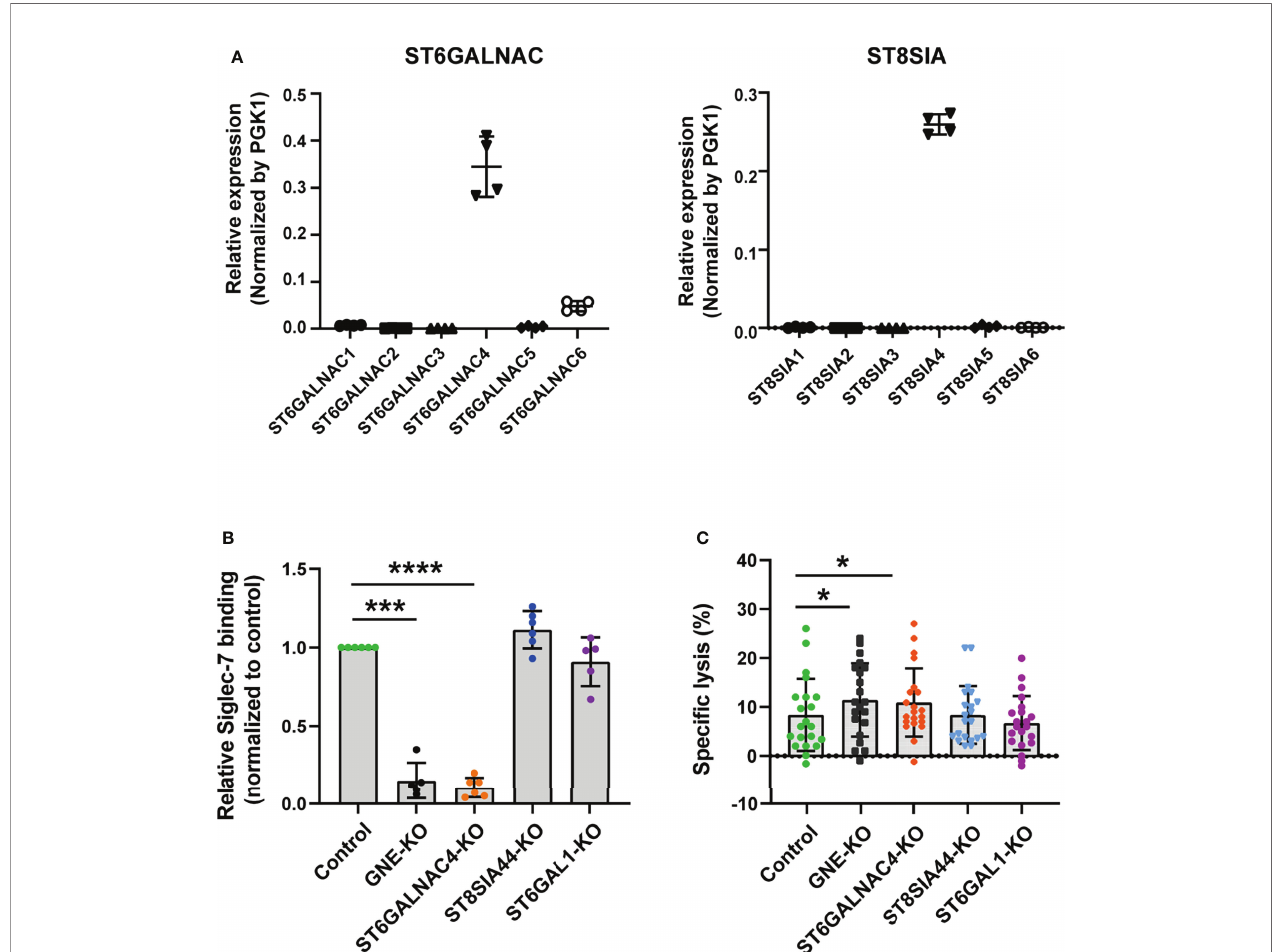
FIGURE 4 | ST6GalNAc-IV is responsible for Siglec-7 ligand glycotope synthesis. (A) Sialyltransferases expressed in JVM-3. The transcript level for ST6GALNAC4 was the highest among ST6GALNAC s, whereas that for ST8SIA4 was the highest among ST8SIA s. Bars represent mean ± SD of technical quadruplicates. (B) Effect of sialyltransferase KO on Siglec-7 – Fc binding. GNE and sialyltransferase genes ( ST6GALNAC4 , ST8SIA4 , and ST6GAL1 ) in JVM-3 were disrupted with CRISPR – Cas9 technology, and the cells were subjected to staining with Siglec-7 – Fc. The disruption of GNE and ST6GALNAC4 led to a marked reduction in Siglec-7 – Fc binding, whereas the disruption of ST8SIA4 and ST6GAL1 did not. Data was normalized by the Siglec-7 – Fc binding (in MFI) to control JVM-3 cells. *** P < 0.001, and **** P < 0.0001, one-way ANOVA with Dunnett ’ s post hoc test. Bars represent mean ± SD of 6 independent experiments. (C) Effect of sialyltransferase KO on NK cell cytotoxicity. Sialyltransferase KO and control JVM-3 cells were subjected to NK cell cytotoxicity assay. The disruption of GNE and ST6GALNAC4 led to increased sensitivity of JVM-3 cells to NK cytotoxicity, whereas the disruption of ST8SIA4 and ST6GAL1 did not (* P < 0.05, repeated-measures one-way ANOVA with Dunnett ’ s post hoc test). Bars represent mean ± SD of 21 independent experiments.